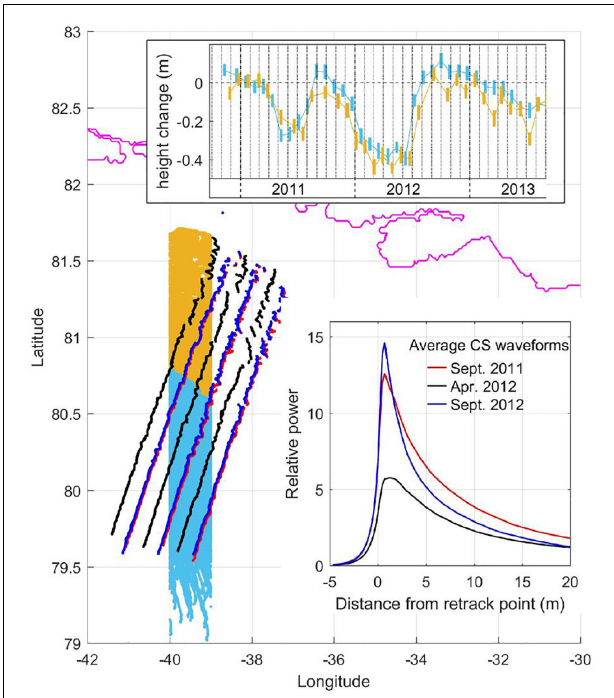
FIGURE 12 | Positions of the CryoSat data in the basin 1.3 test site are shown as 88,906 fawn dots ( < 2000 m) and 100,182 light blue dots ( > 2000 m). The 30-day temporal height change derived from these two data sets are shown in the upper insert plot using the same colors. Over 2000 CryoSat footprint positions are shown from each of 3 descending passes in 3-time frames; September 2011 in red, April 2012 in black and September 2012 in blue. The average waveform from each time frame is plotted in the lower insert graph using resampled waveforms such that the retracked position was set to